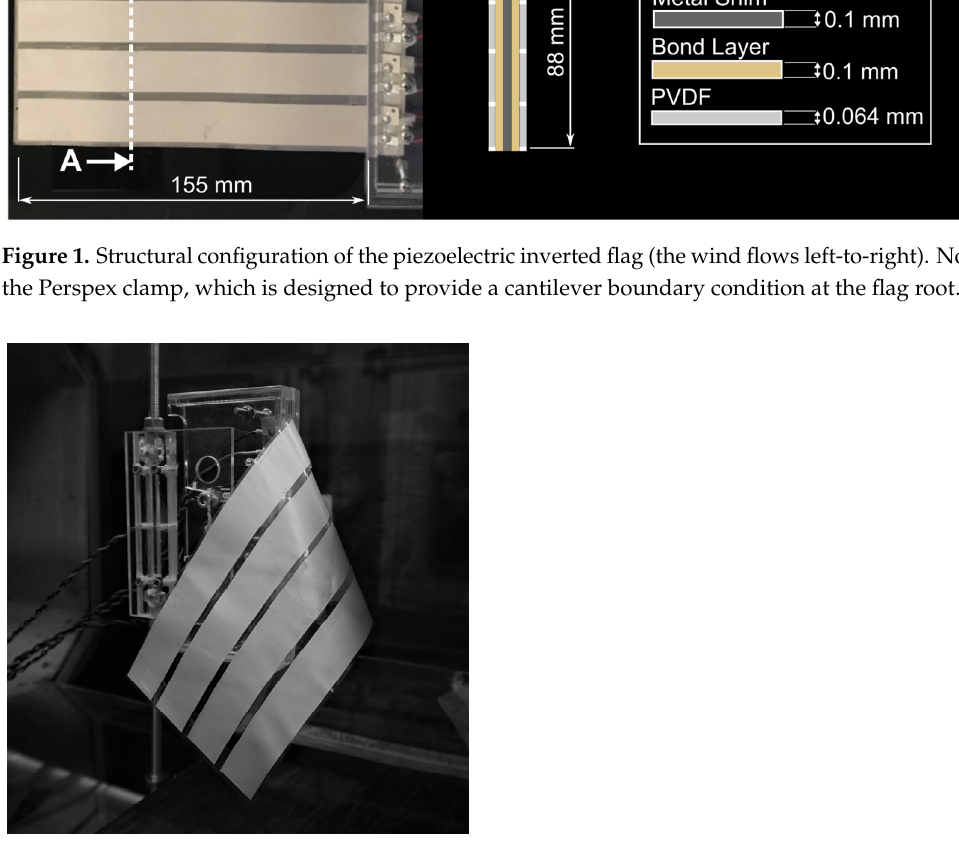
Figure 2. Non-composite flag realized without supporting core: the present PVDF strips are so loose that the flag folds over on itself. Figure adapted from [20]. that the flag folds over on itself. Figure adapted from